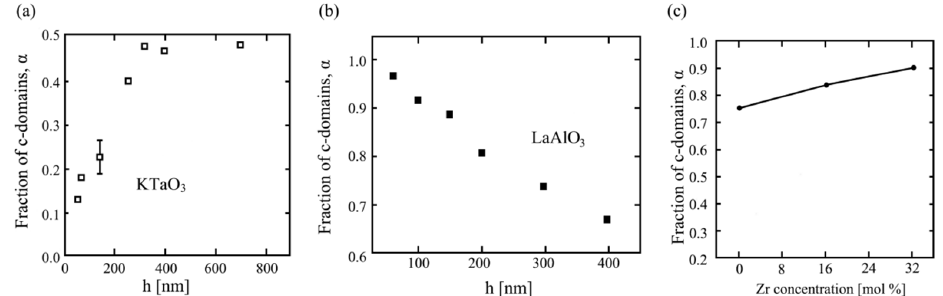
Figure 10. ( a , b ) C-domain fraction versus film thickness. ( a ) PbTiO 3 film on the KTaO 3 substrate shows that as the thickness increases, the c-domain fraction increases. Reprinted with permission from [118] 1994 American Physical Society; ( b ) Pb(Zr 0.2 Ti 0.8 )O 3 film on the LaAlO 3 substrate shows that as the thickness increases, the c-domain fraction decreases. Reprinted with permission from [91] 1999 AIP Publishing. ( c ) C-domain fraction with Zr concentration in Pb(Zr,Ti)O 3 film shows that as Zr concentration increases, the c-domain fraction increases. Reprinted with permission from [119] 2012 Springer Nature .